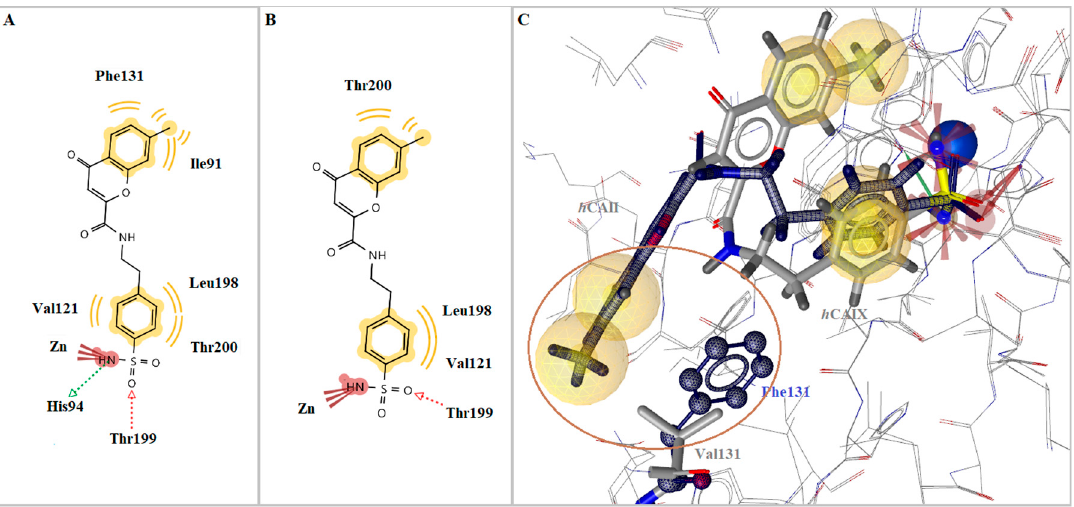
Figure 2. ( A ) 2D interaction diagram of compound 17 docking pose interactions with the key amino acids in hCA II, ( B ) in hCA IX, and ( C ) superposition of compound 17 bound to hCA IX (grey) in comparison to hCA II (blue), with specific residues labeled. Active site zinc is shown as a blue sphere, red dotted and green arrows indicate H-bond, and yellow spheres indicate hydrophobic interactions. Brown circle .